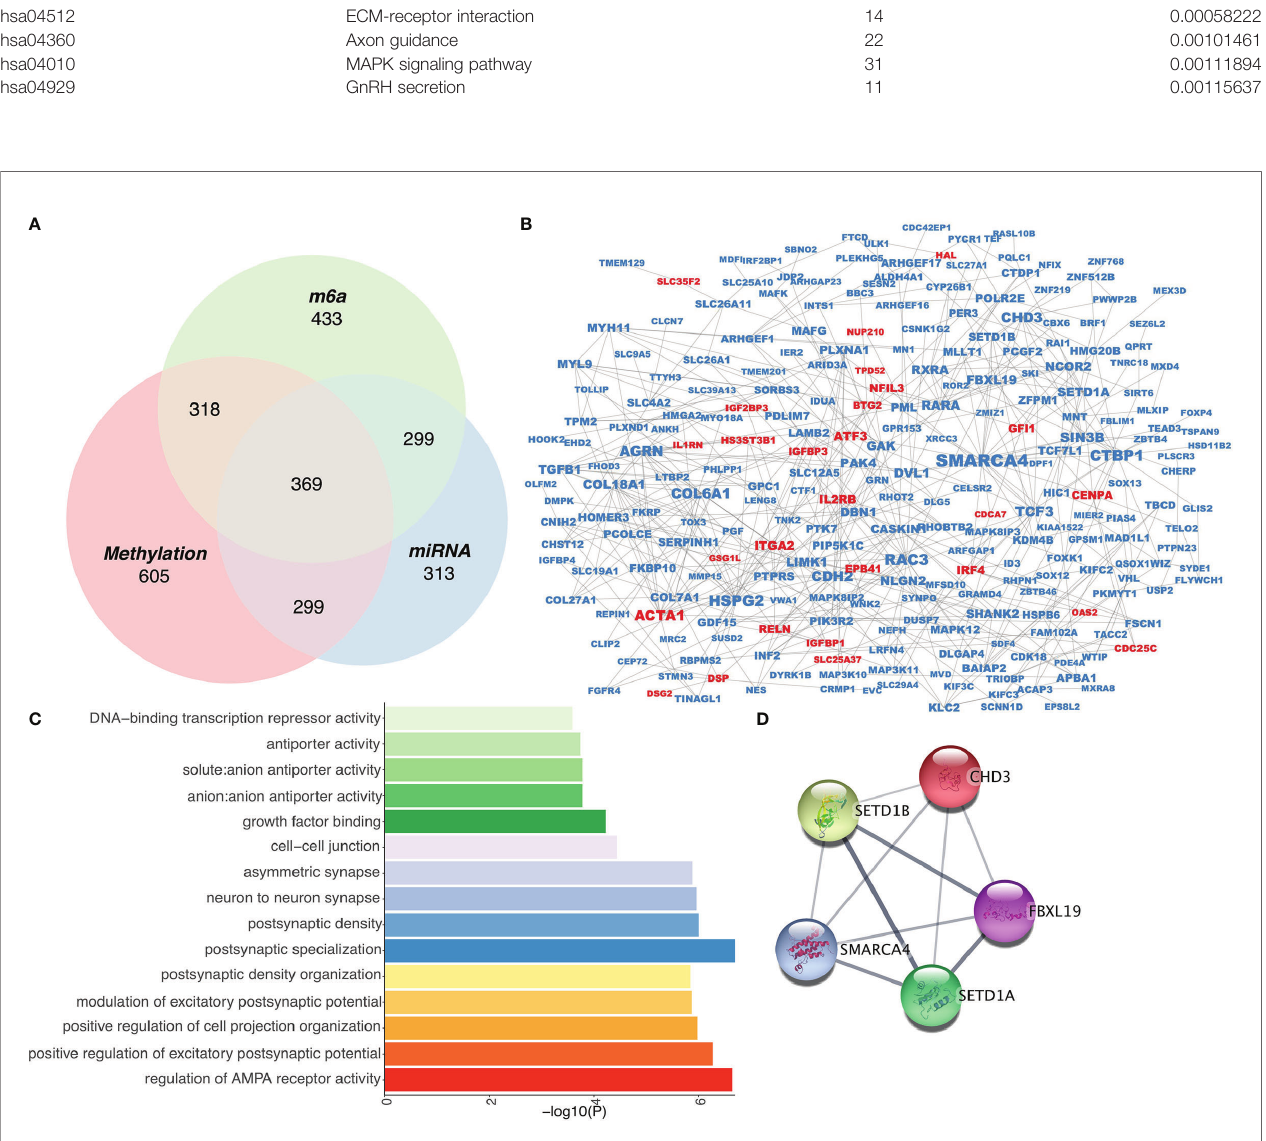
FIGURE 3 | Construction of an epigenetic regulatory network in RA. (A) Venn diagram of three epigenetic regulation-related gene screens. (B) Protein-protein interaction network of epigenetically regulated genes. (C) Gene Ontology analysis of epigenetically regulated genes. (D) Interaction network among hub